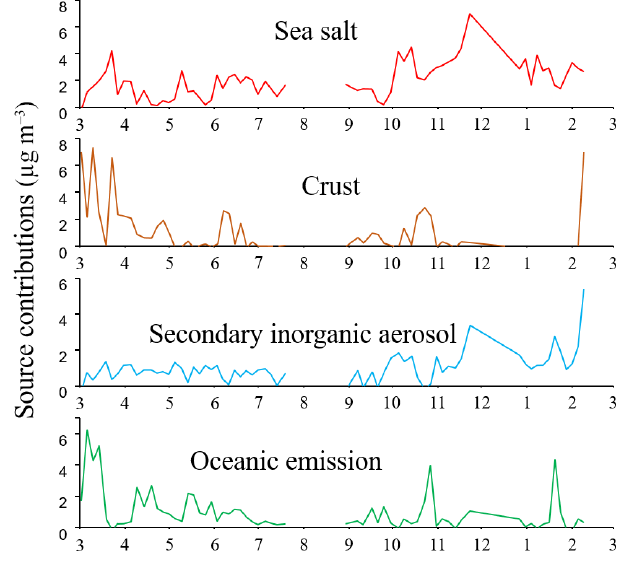
Figure 10. Time series contributions from each identified sources, including sea salt (two species), crust, secondary inorganic aerosol, and oceanic